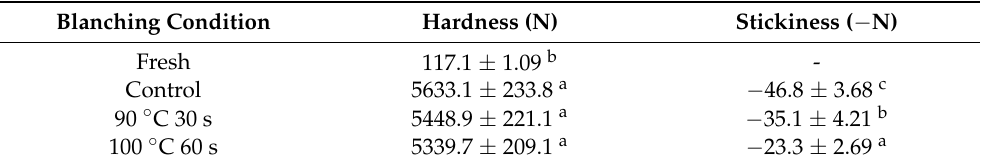
Table 2. Changes in the hardness and stickiness of dried pomegranate arils for different blanching conditions. Blanching